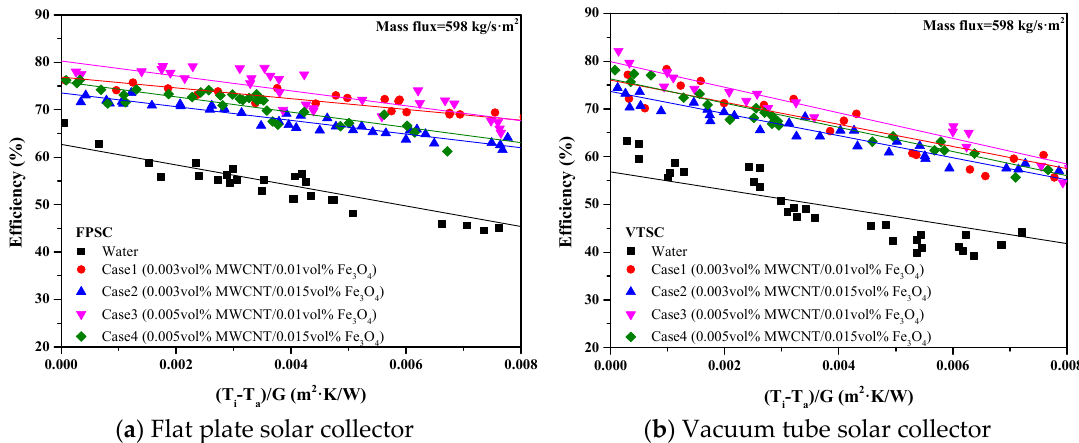
Figure 5. The e ffi ciency of the flat plate and vacuum tube solar collector using water and MWCNT / Fe 3 O 4 Figure 5. The efficiency of the flat plate and vacuum tube solar collector using water and binary nanofluid (Mass flux = 598 kg / s · m 2 MWCNT/Fe 3 O 4 binary nanofluid (Mass flux = 598 kg/s ∙ m 2 ).